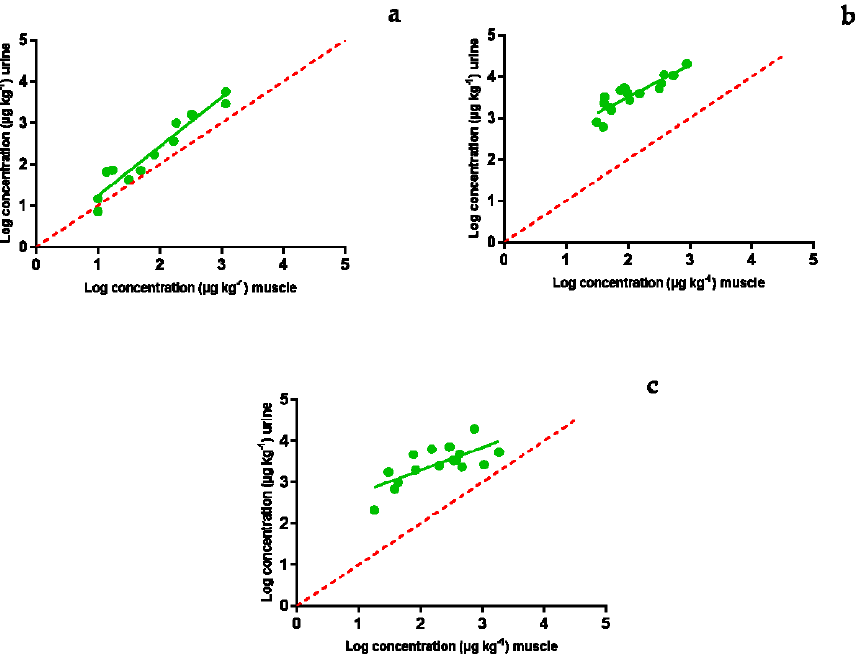
Figure 4. Relationship among the concentrations of sulfamethoxypyridazine ( a ), oxytetracycline ( b ), and enrofloxacin ( c ) detected in muscle and urine samples. The bisecting dotted line represents the 1:1 correlation if both matrixes contained the same concentration of enrofloxacin.